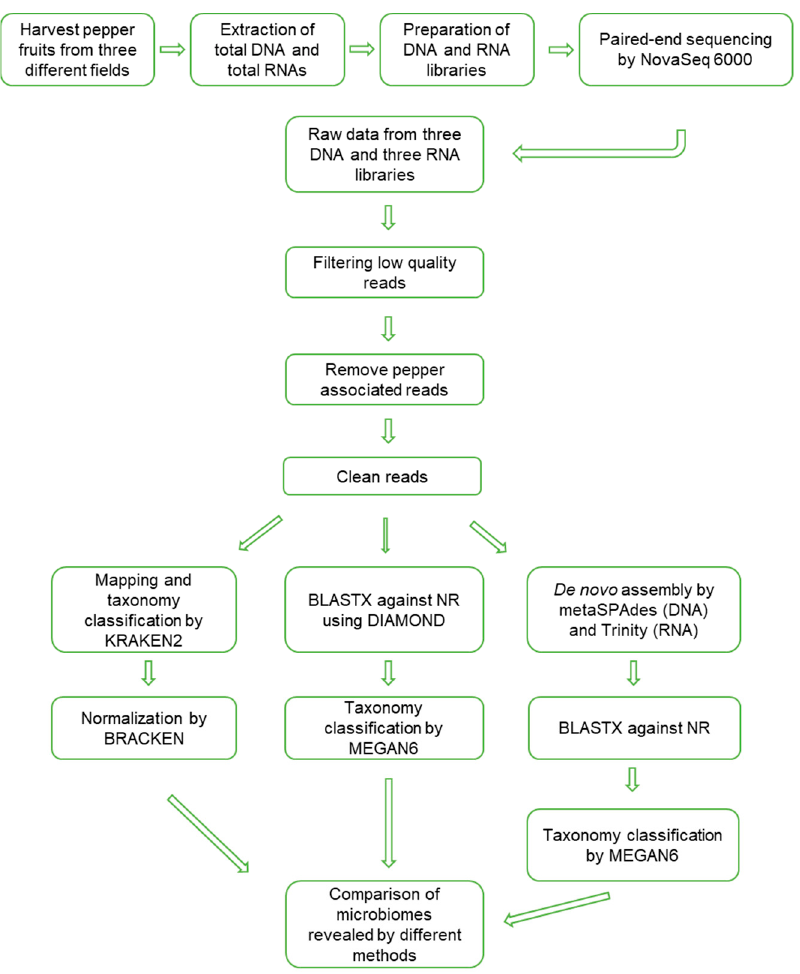
Figure 2. Schematic diagram to analyze microbiomes in overwintering pepper fruits using metagenomics and metatranscriptomics.